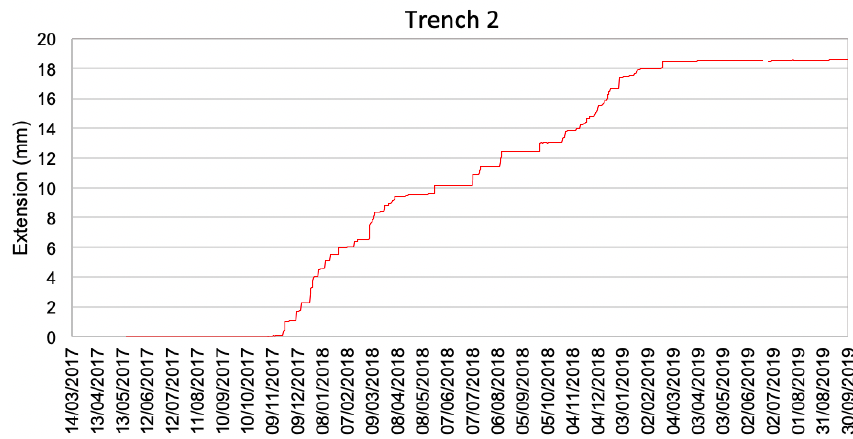
Figure 7. Graph showing the readings of the incremental extension (in mm), associated with landslide surface displacement, and recorded from May 2017 to September 2019 by station no.